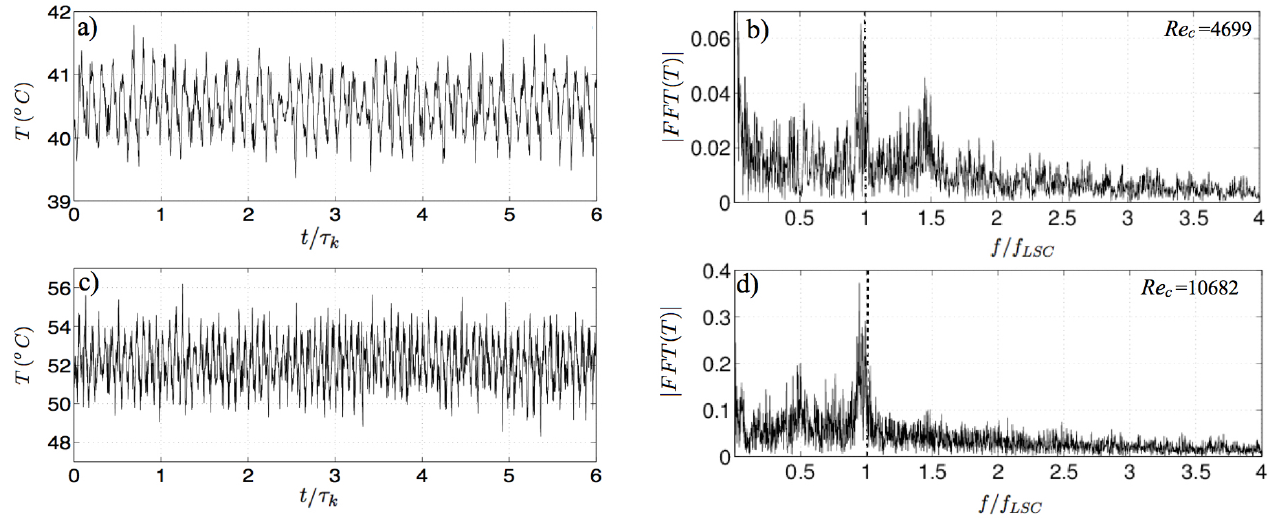
Figure 9. Temperature time series (left) and Fourier spectra (right) from the RBC 3 RBC 4 ( c , d ) laboratory experiments, carried out in the Γ (cid:39) 2 tank, and at Ra = 5 . 6 × 10 5 and l Ra = 2 . 8 × 10 6 , respectively. Data collection starts once statistically-steady conditions have (cid:39) 1 . 5 in panel b was first predicted using the been reached. The spectral peak at f/f LSC SFEMaNS case results that showed that the flow spent significant time in the n = 2 RBC 3 n two-roll